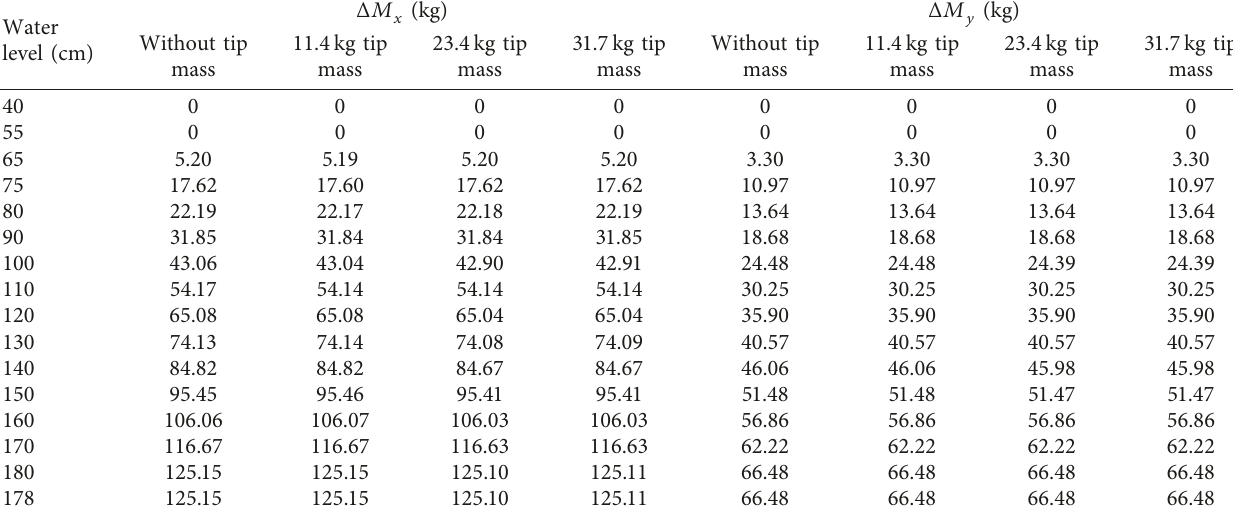
Table 3: HAM along the x -axis and y -axis for the four tip masses in case